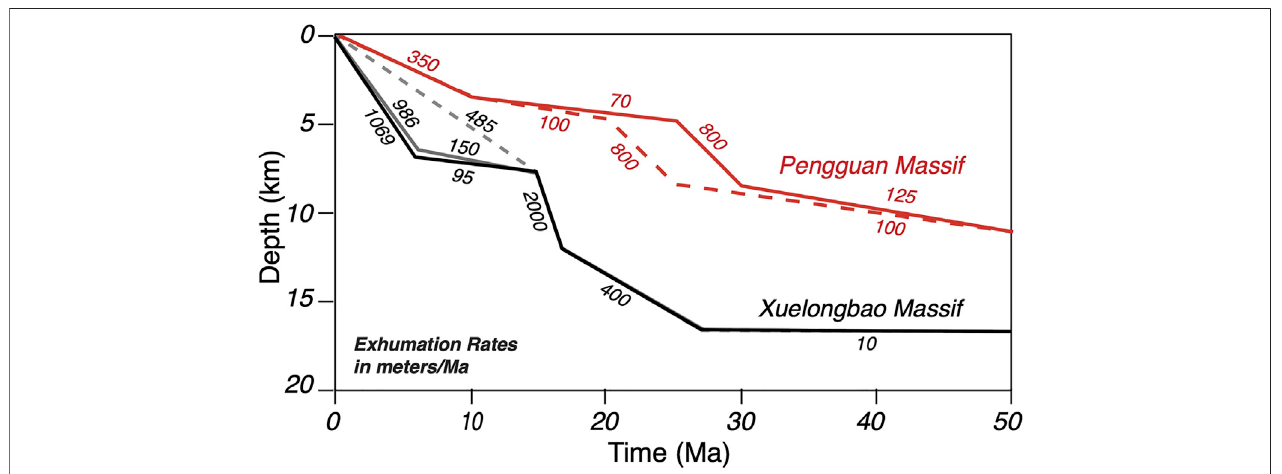
FIGURE 11 | Modeled Exhumation Histories for the Pengguan Massif (Wang et al., 2012) and the Xuelongbao Massif (this study) since 50 Ma. Exhumation rates (meters/Ma) for each exhumation stage are labeled on the graph. The two curves for the Pengguan Massif model re fl ect the range of models determined in that study. The three curves for the Xuelongbao model are the three models presented in Figures 8 , 9